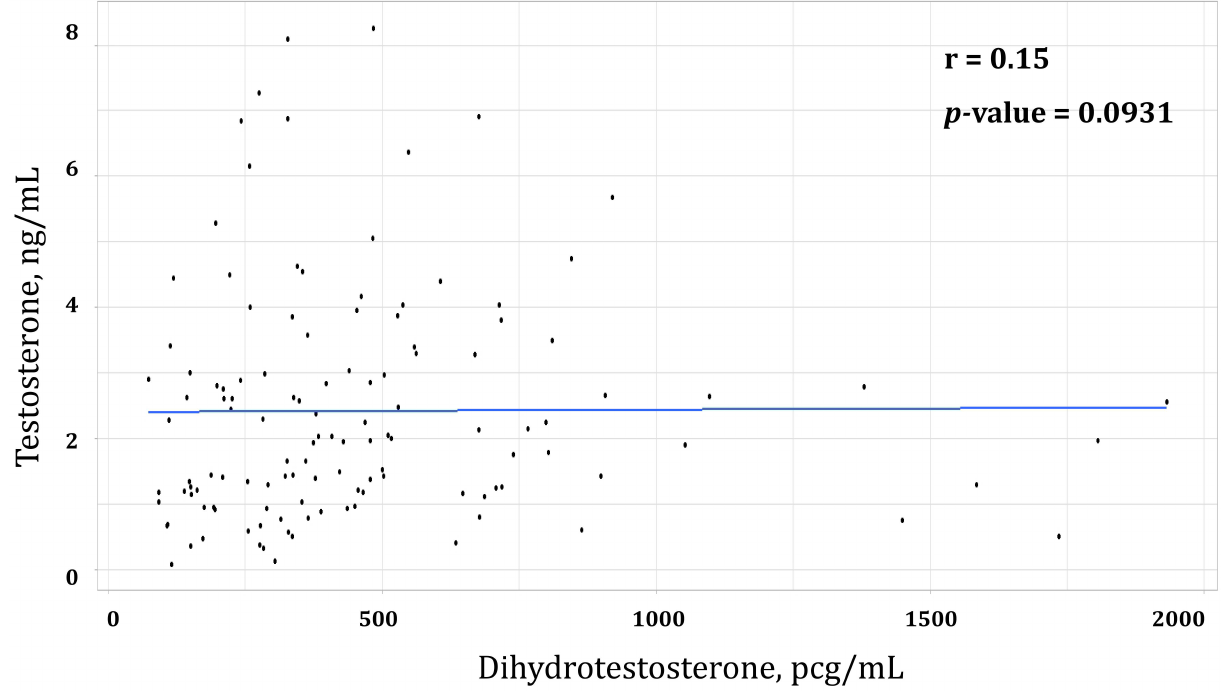
FIGURE 1. Correlation between DHT and T serum blood levels. Cobas 6000). The lower reference value of the normal DHT in males, in accordance with the instructions for the test system, were 175 pcg/mL (range—175–1204 pcg/mL).